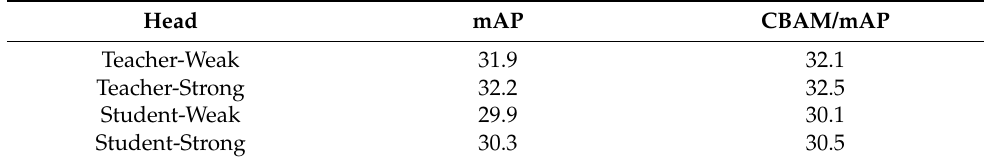
Table 3. Ablation experimental results of strong and weak heads for teacher-student models.